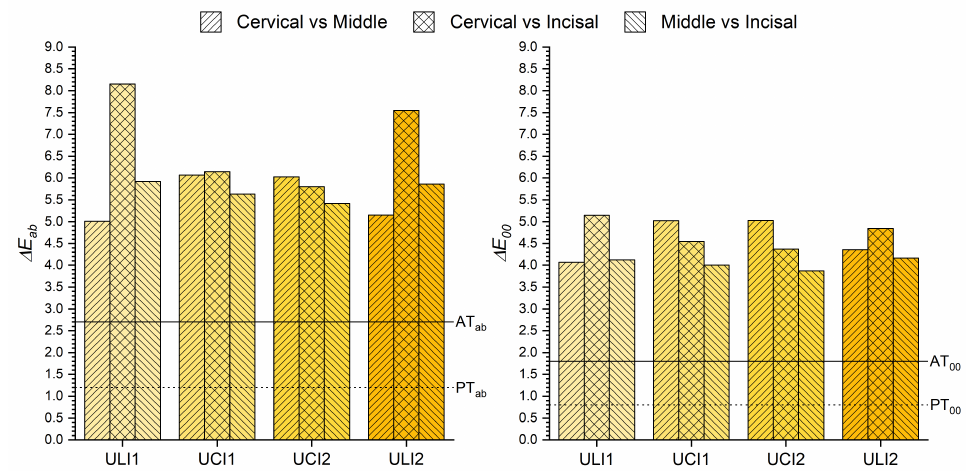
Figure 5. ∆ E ∗ and ∆ E 00 color differences between the cervical, middle and incisal thirds of the ab same